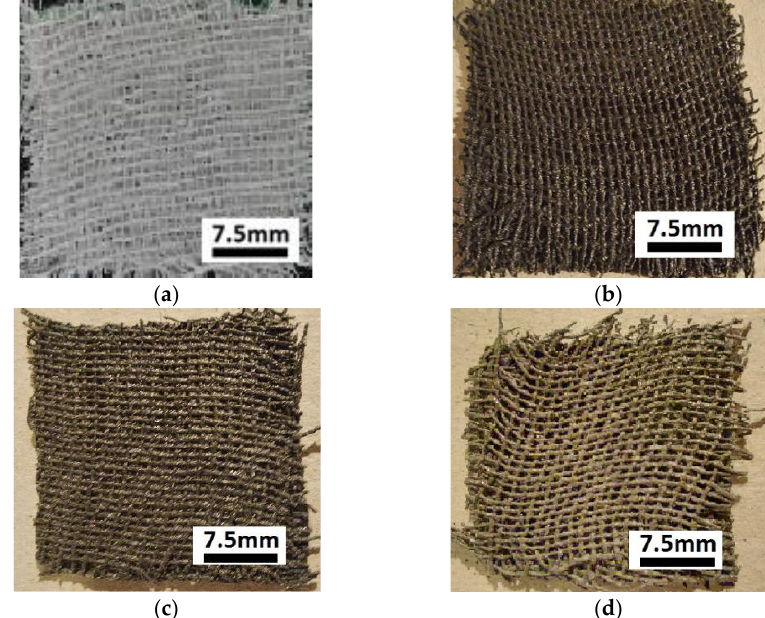
Figure 2. Images of M 𝑖 (𝑖 = 0,1,2,3) membranes: ( a ) M 0 ; ( b ) M 1 ; ( c ) M 2 ; ( d ) M 3 . Each membrane was weighed on an analytical balance (ALN 60, produced by AXIS, Gdansk, Poland), and the obtained masses 𝑚 M ( i = 0, 1, 2, 3 ) are shown in Table 1. Given 𝑚 GB = 0.200 g and the values of 𝜑 HB , 𝜑 CI , and 𝜑 SmP from Table 1, we calculated 𝑚 M − 𝑚 GB (𝑖 = 0,1,2,3) to obtain the values of 𝑚 HB , 𝑚 CI , and 𝑚 SmP given in Table 2. Table 2. Masses of components in the membranes M 𝑖 (𝑖 = 0,1,2,3) .